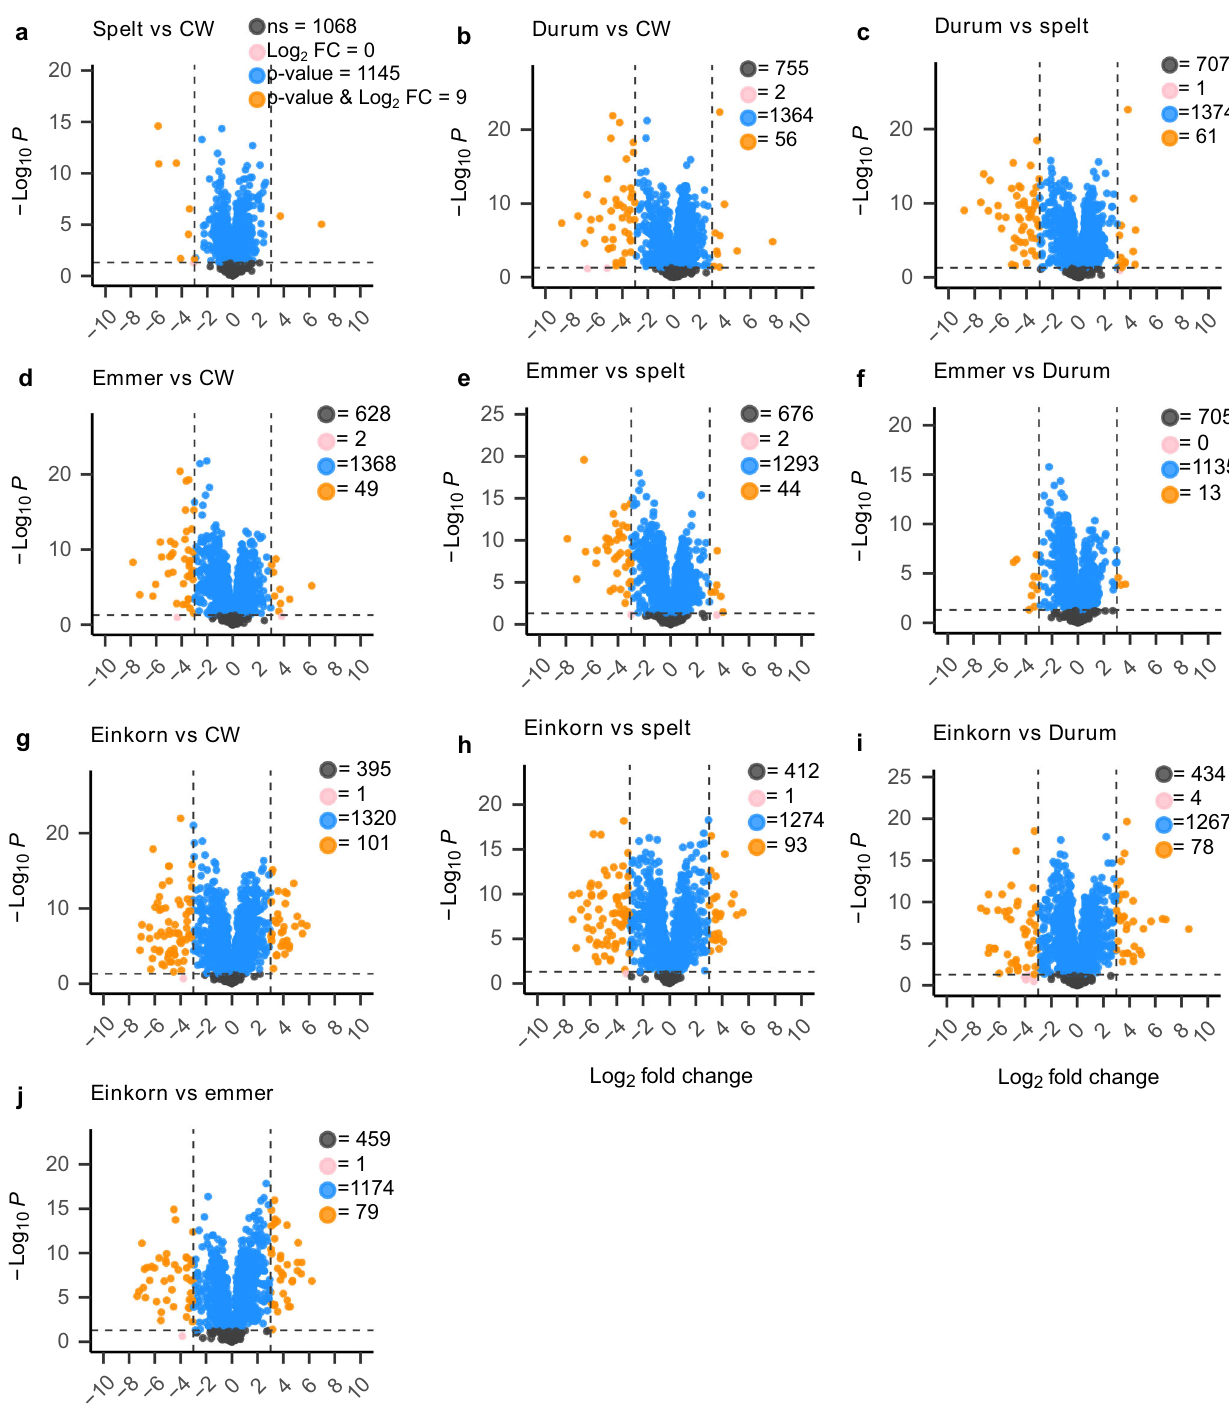
Fig. 3 Results of the comparisons for individual proteins between different pairs of wheat species. a – j Volcano plots of proteins that were common between different pairs of wheat species. The x-axis shows the log2-scale fold change (Log2FC) in the LFQ abundance of proteins between two species. The y-axis shows the negative log10-scale p value from the t-test. The vertical dashed lines denote ±3 Log2FC threshold, while the horizontal dashed line denotes p value threshold of 0.05, e.g., the orange points in ( a ) show proteins, which are downregulated (Log2FC < -3) or upregulated (Log2FC > 3) in spelt compared to common wheat and passed both thresholds i.e., p value and Log2FC. Color of the points represents signi fi cance status of proteins for p value (<0.05) and Log2FC (±3): gray, non-signi fi cant for both thresholds; pink, signi fi cant Log2FC only; blue, signi fi cant p value only; orange, signi fi cant for both thresholds. CW, common